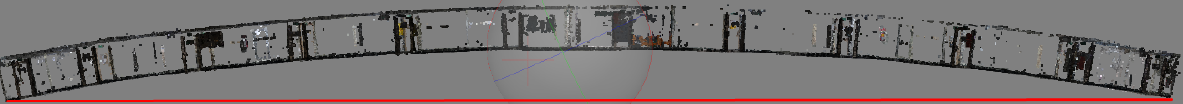
Figure 5. Sparse cloud from spherical images obtained banana effect, it caused by camera model and uncalibrated spherical images .